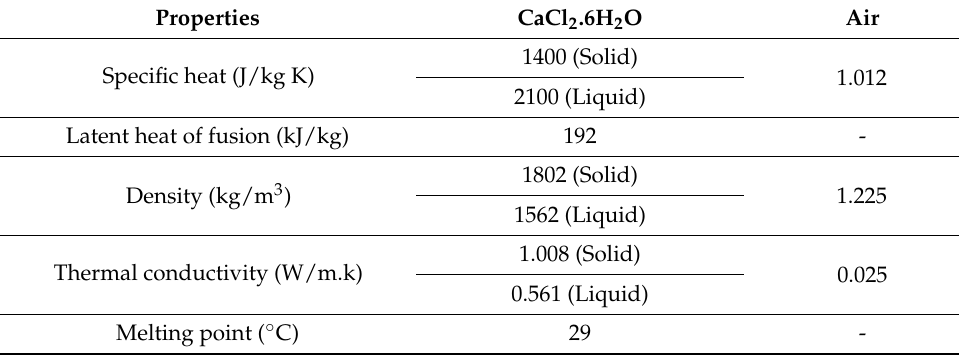
Table 2. Thermophysical properties of PCM and air.